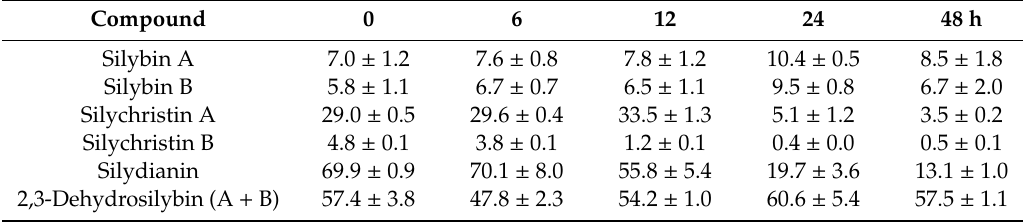
Table 1. The concentration ( µ M) of the parent flavonolignans during the fecal